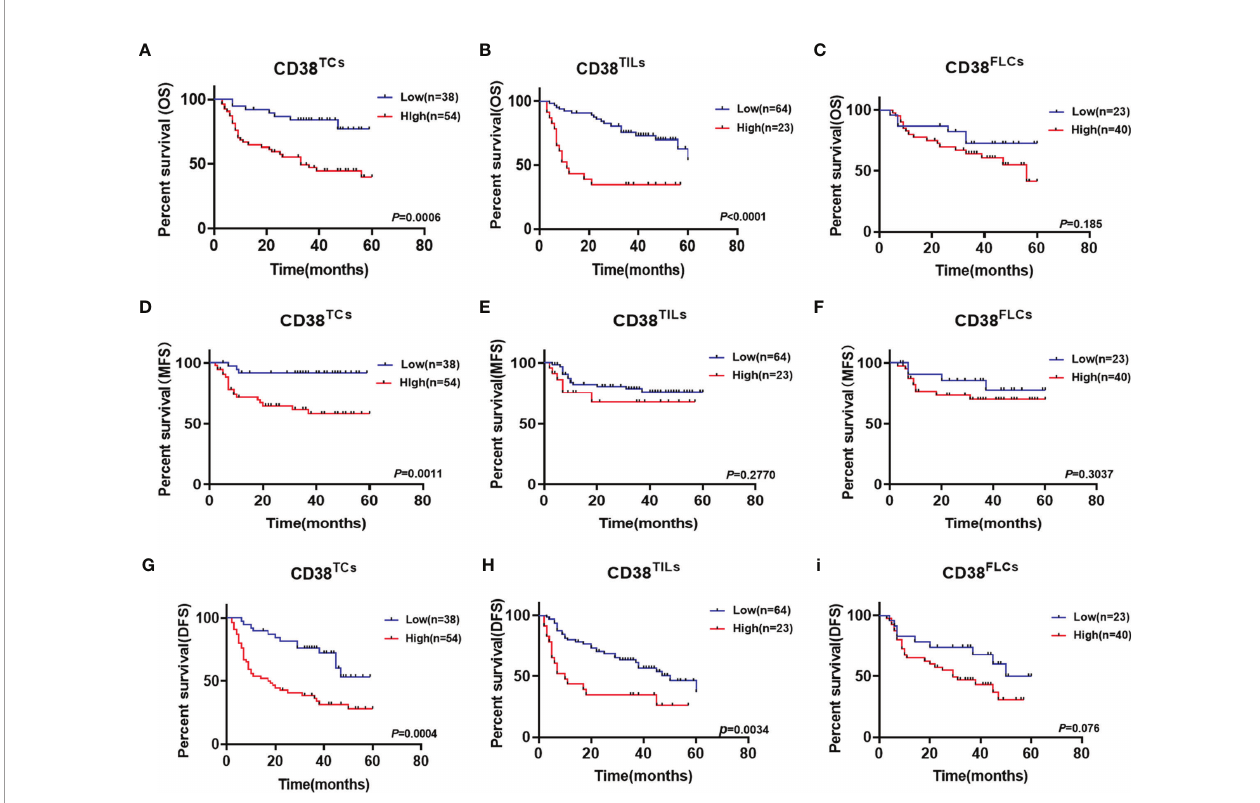
FIGURE 3 | Kaplan – Meier survival curves for overall survival time (A – C) , metastasis free survival time (D – F) and disease-free survival time (G – I) of OSCC patients according to the expression of CD38 in TCs, TILs and